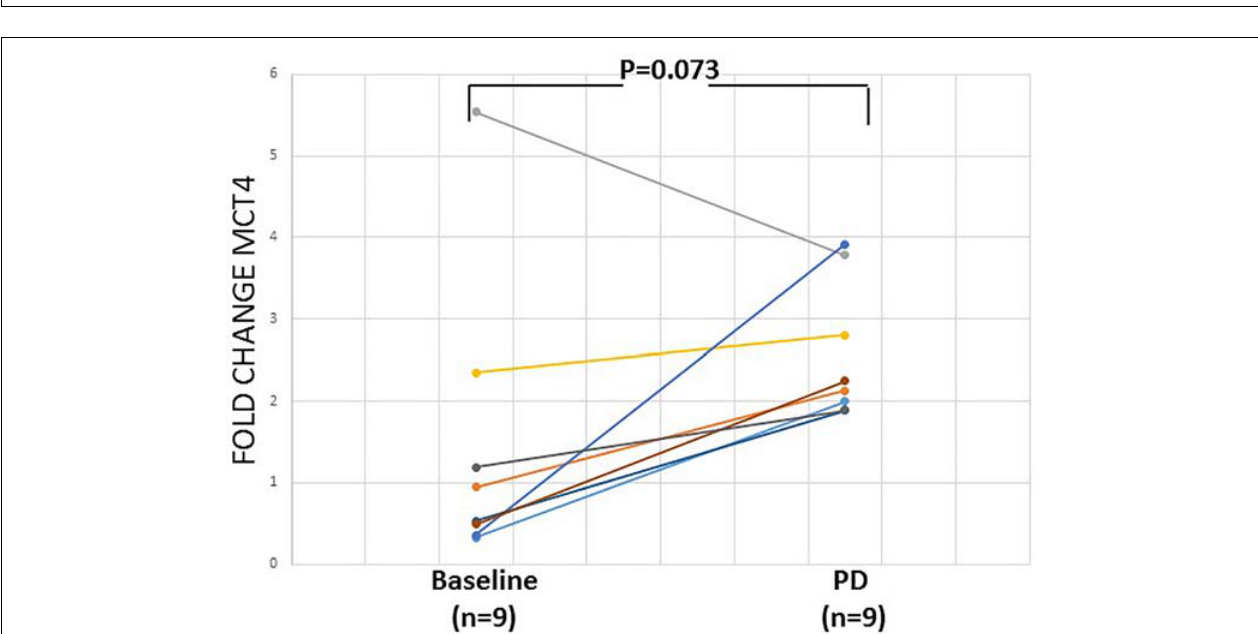
FIGURE 3 | Expression levels of MCT4 in CTC fractions of HD ( n = 10) and early stage NSCLC patients ( n = 53).